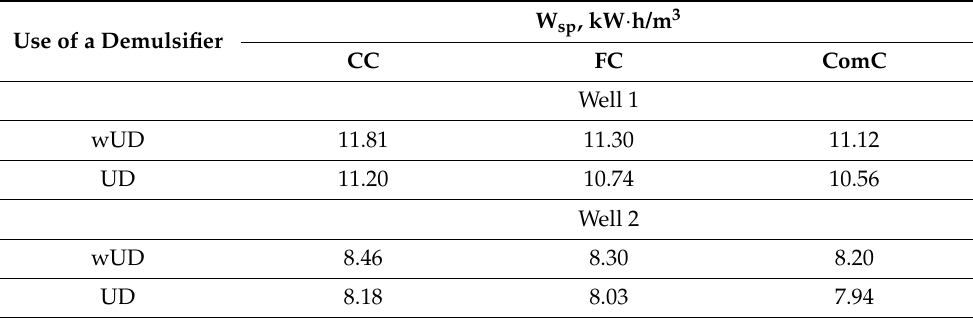
Table 6. The calculation results of specific power consumption with different control